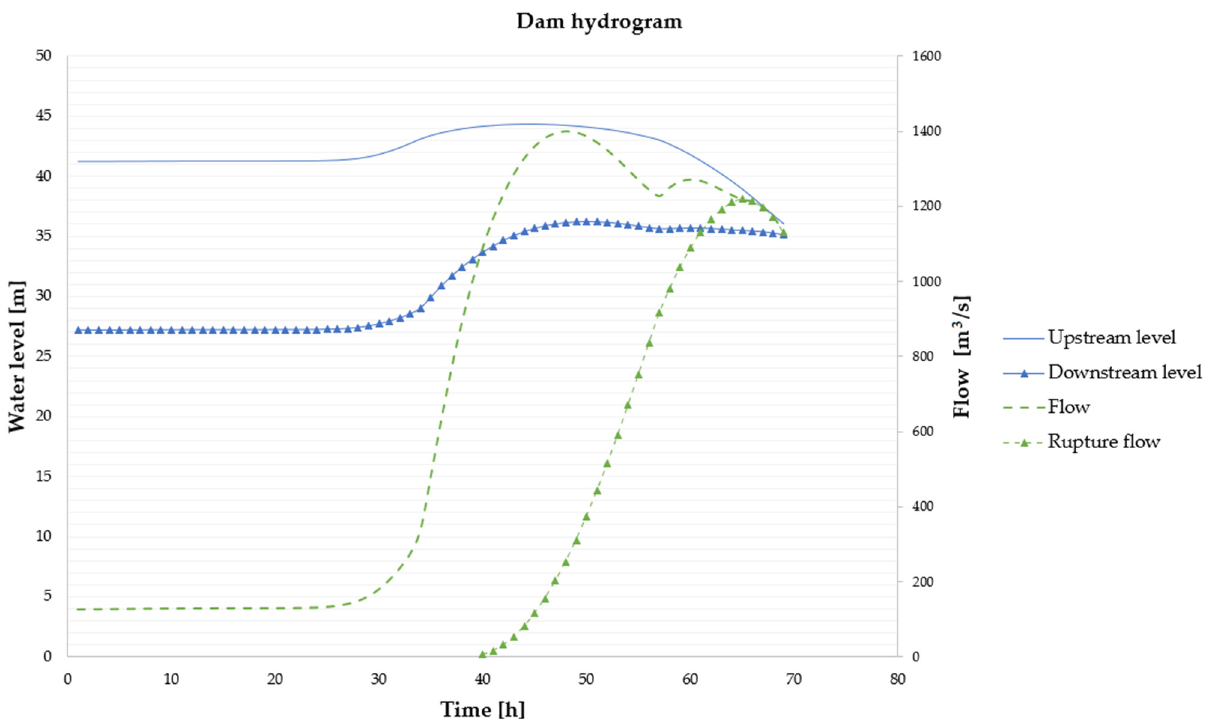
Figure 10. Failure hydrograph scenario B.